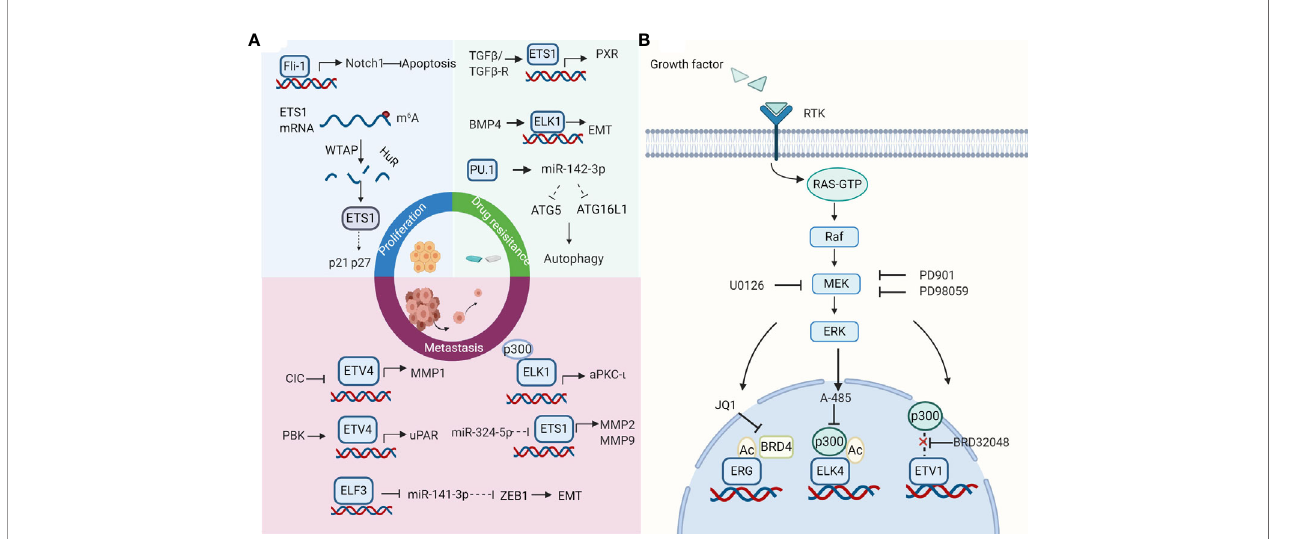
FIGURE 1 | Roles and therapeutic strategies of the E-twenty-six (ETS) family. (A) Effects of ETS family on hepatocellular carcinoma (HCC) cells. ETS factors take part in cell proliferation, invasion, metastasis, and drug resistance in HCC. Selected examples of ETS factors and their upstream factors or genomic targets are shown. Diagram is adapted from reference (63). (B) ETS transcription factors as therapeutic targets. The strategies for targeting ETS factors include breaking its association with protein partners, inhibiting its regulatory pathways, using its small molecule inhibitors. The strategy of combination therapy to target the ETS family in cancers appears to be a promising way for future research. Created with